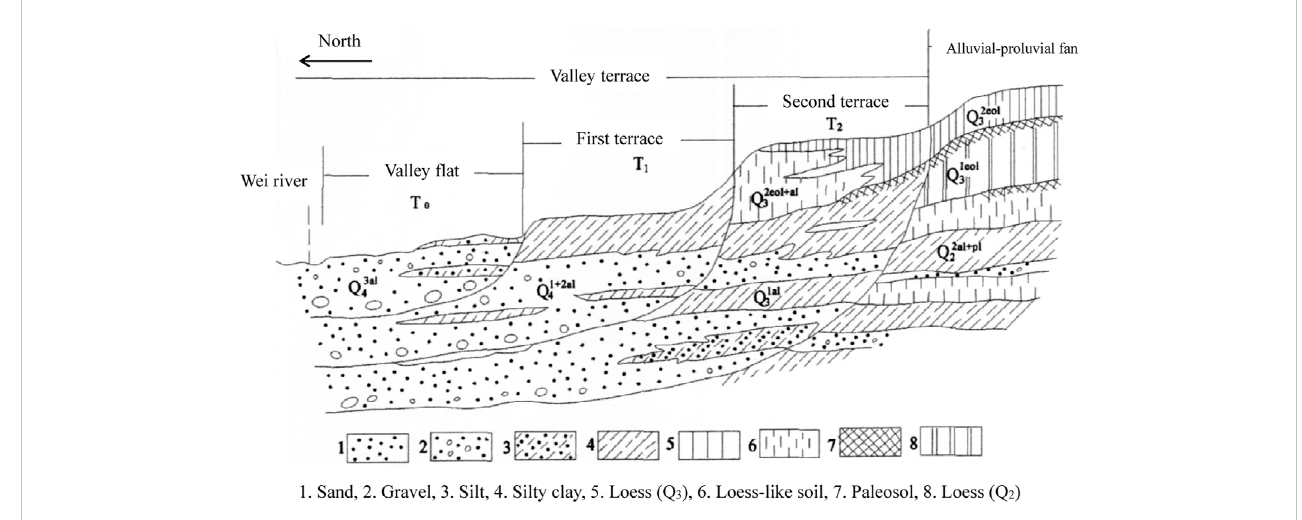
FIGURE 2 Cross section of Wei River terraces. 1. Sand, 2. Gravel, 3. Silt, 4. Silty clay, 5. Loess(Q3), 6. Loess-like soil, 7. Paleosol, 8. Loess(Q2).